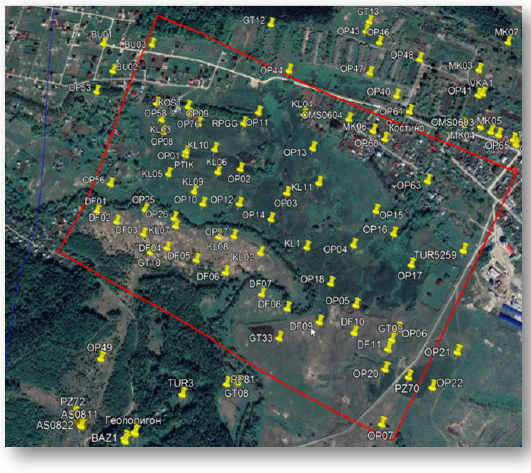
Figure 1. The layout of the targeted ground control points. side overlap Py =80%, speed of unmanned aerial vehicle of 72 km/h. For the specified AGL the GSD of aerial photos is equal 3.3 cm.To the specified AGL corresponds the spatial resolution of aerial photographs equal 3.3